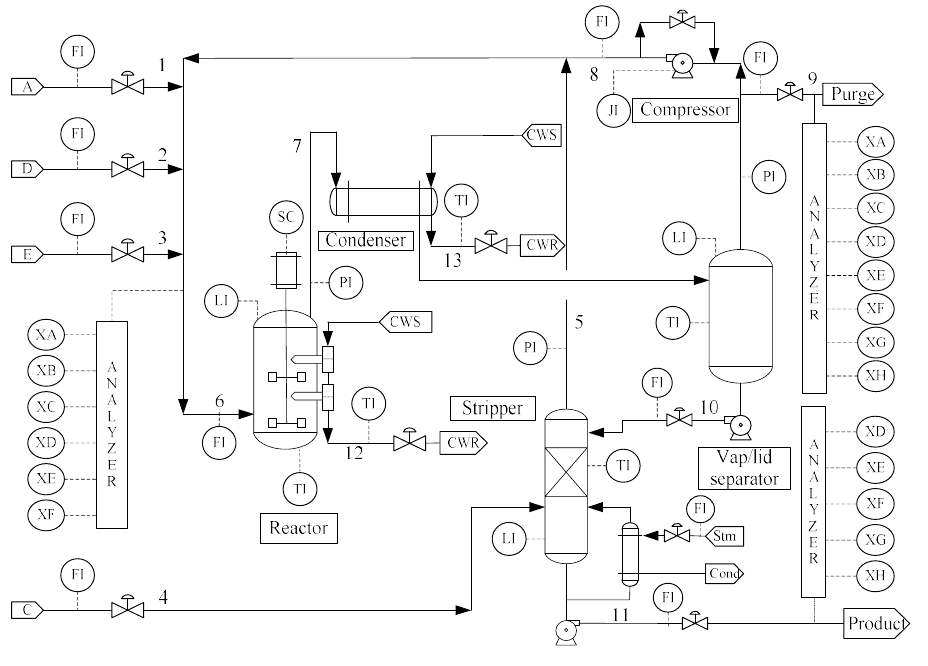
Figure 3. Flowchart of TE chemical process.